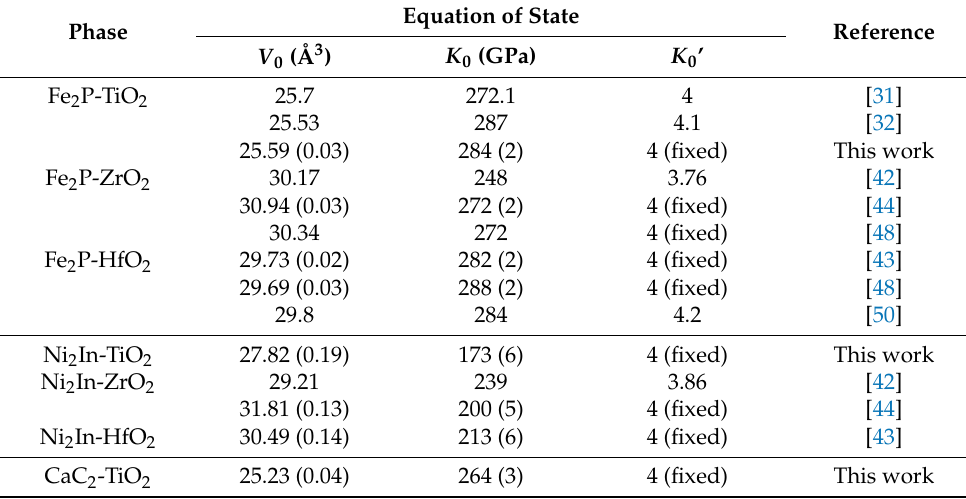
Table 1. Calculated equations of state for the Fe 2 P, Ni 2 In, and CaC 2 phases of TiO 2 . Our EOS is determined from GGA calculations using the second-order BM-EOS [57]. For comparison, we list other calculated EOSs for TiO 2 and the similar dioxides ZrO 2 and HfO 2 . 1 σ uncertainties are given in